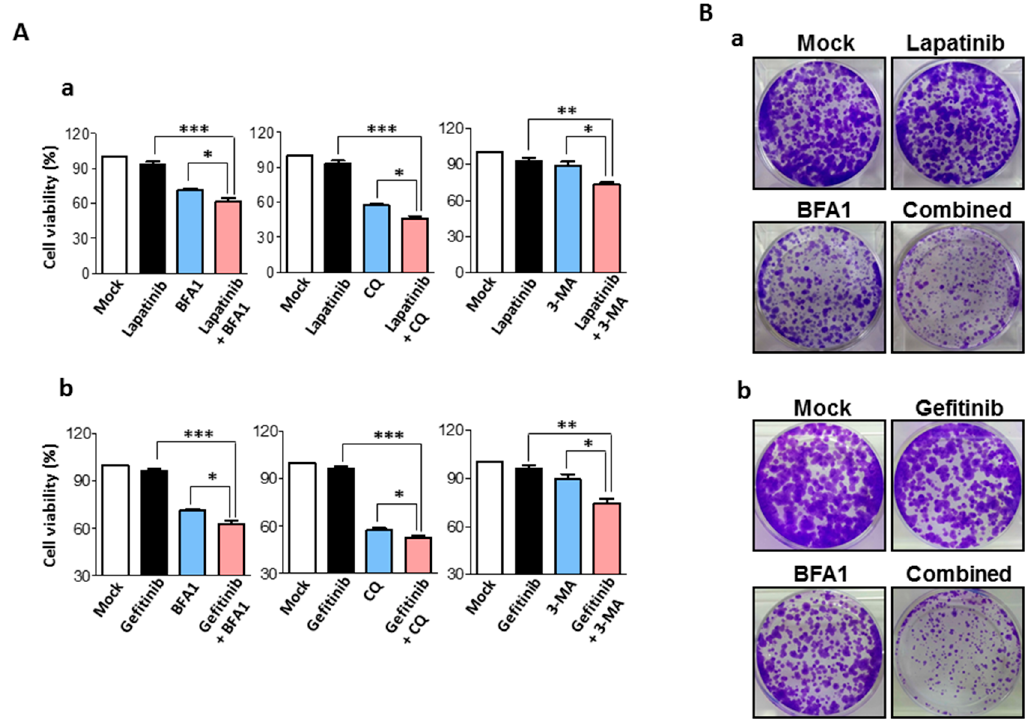
Figure 3. Synergistic anti-cancer effects of EGFR inhibitors and autophagy inhibitors on T24 human bladder cancer cells. ( A ) Evaluation of anti-cancer effects of ( a ) lapatinib and ( b ) gefitinib treatments in T24 human bladder cancer cells by cell viability tests under different treatment combinations (control, 5 µ M of EGFR inhibitors (lapatinib; gefitinib), autophagy inhibitors and both agents) for 24 h. Autophagy inhibitors used in this study were 5 nM of bafilomycin A1 (BFA1), 10 µ M of chloroquine (CQ) and 10 mM of 3-methyladenine (3-MA). Cell viability is shown as the mean percentage (%) of control ± SEM ( n = 3, * p < 0.05, ** p < 0.01, *** p <0.001); ( B ) clonogenic assay determining the effects of concurrent treatments of ( a ) lapatinib (5 µ M) and ( b ) gefitinib treatments (5 µ M) with autophagy inhibitor BFA1 (5 nM) on clonal proliferation of T24 cells.